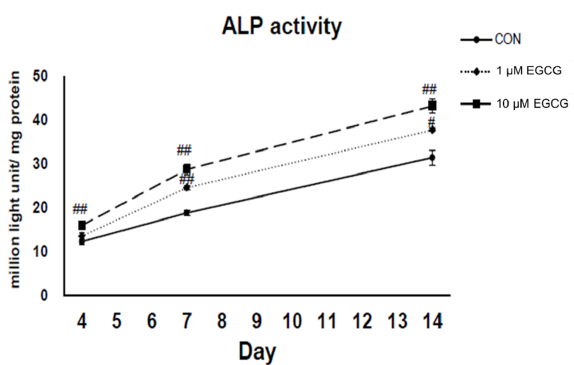
Figure 3. Concentration and time response of ALP activity upregulation by EGCG. In comparison to control cultures, the ALP activities of EGCG (1 and 10 µmol/L)-treated cultures increased by 11% and 30% ( p < 0.05) on the 4th day, 30% ( p < 0.01) and 52% ( p < 0.01) on the 7th day, and 20% ( p < 0.05) and 37% ( p < 0.05) on the 14th day, respectively. # p < 0.05, ## p <